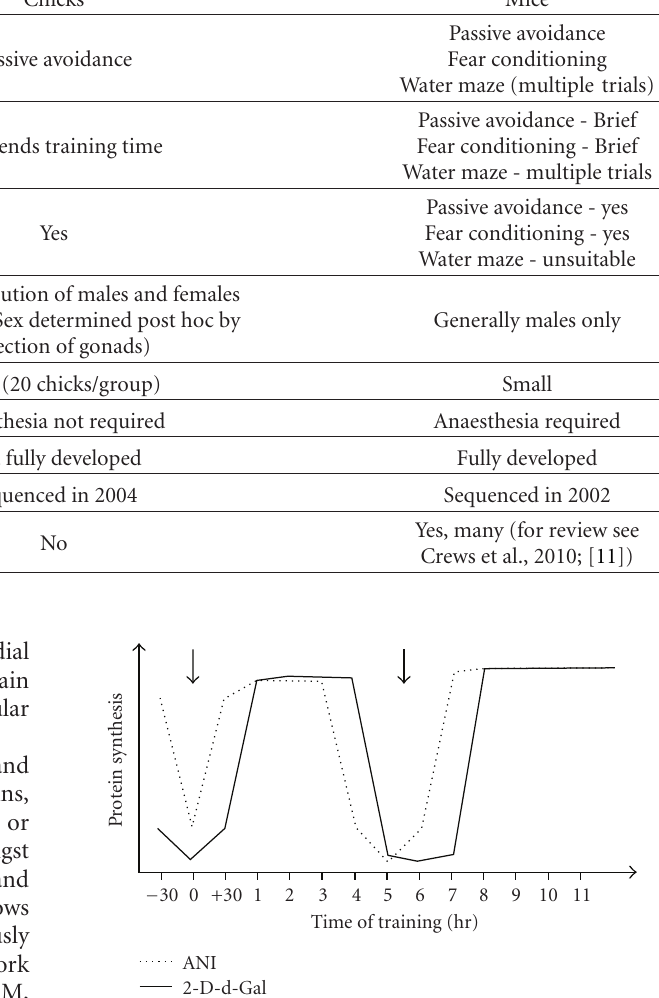
explore the role of APP itself. Chick APP cross-reacts with the mouse monoclonal antibody raised against human